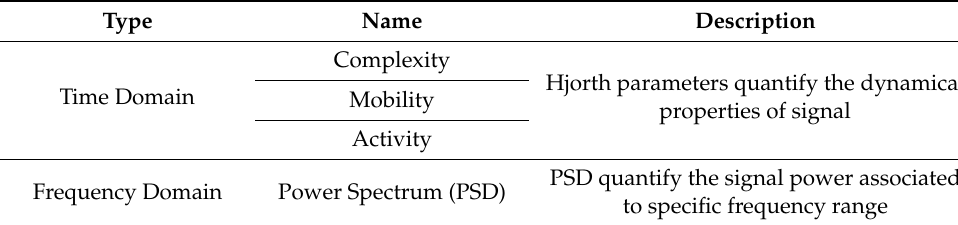
Table 1. EEG features that we extracted and used for our ANN.